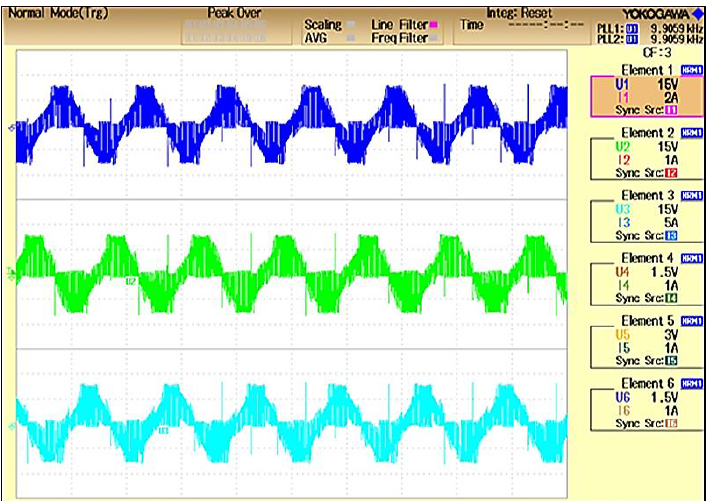
Figure 19. The output voltage waveform of the three-phase inverter. Appl. Sci. 2020 , 10 , x FOR PEER REVIEW